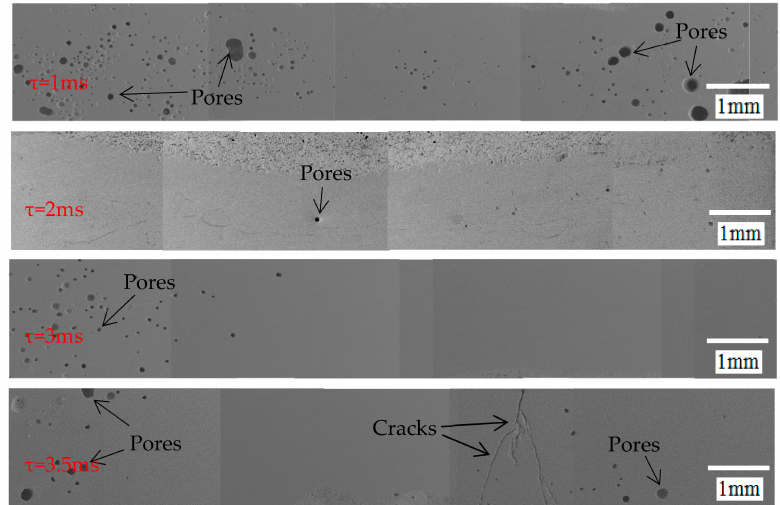
Figure 10. The pores distribution under di ff erent pulse duration times.